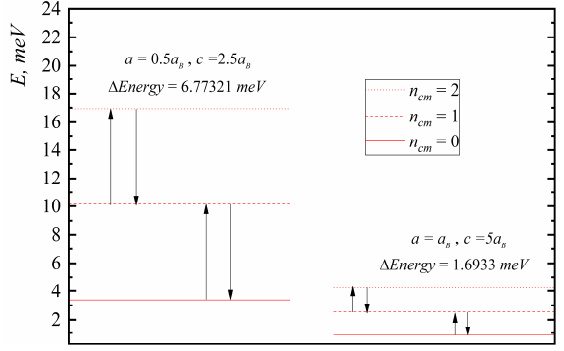
Figure 5. Energy diagram for the center of mass motion for the following values: I. a = 0.5 a B , c = 2.5 a B , Nanomaterials 2020 , 10 , x FOR PEER REVIEW II. a = a B , c = 5 a B .